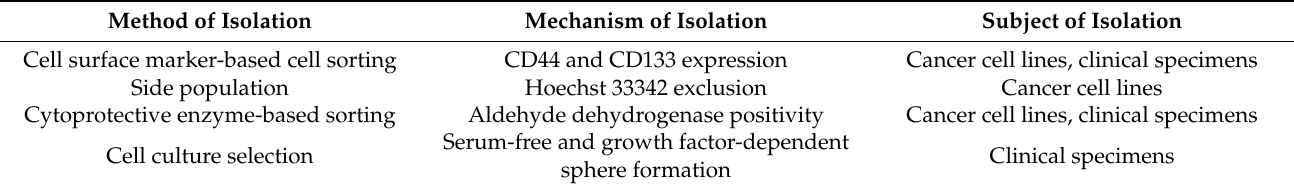
Table 2. CSC isolation in thyroid